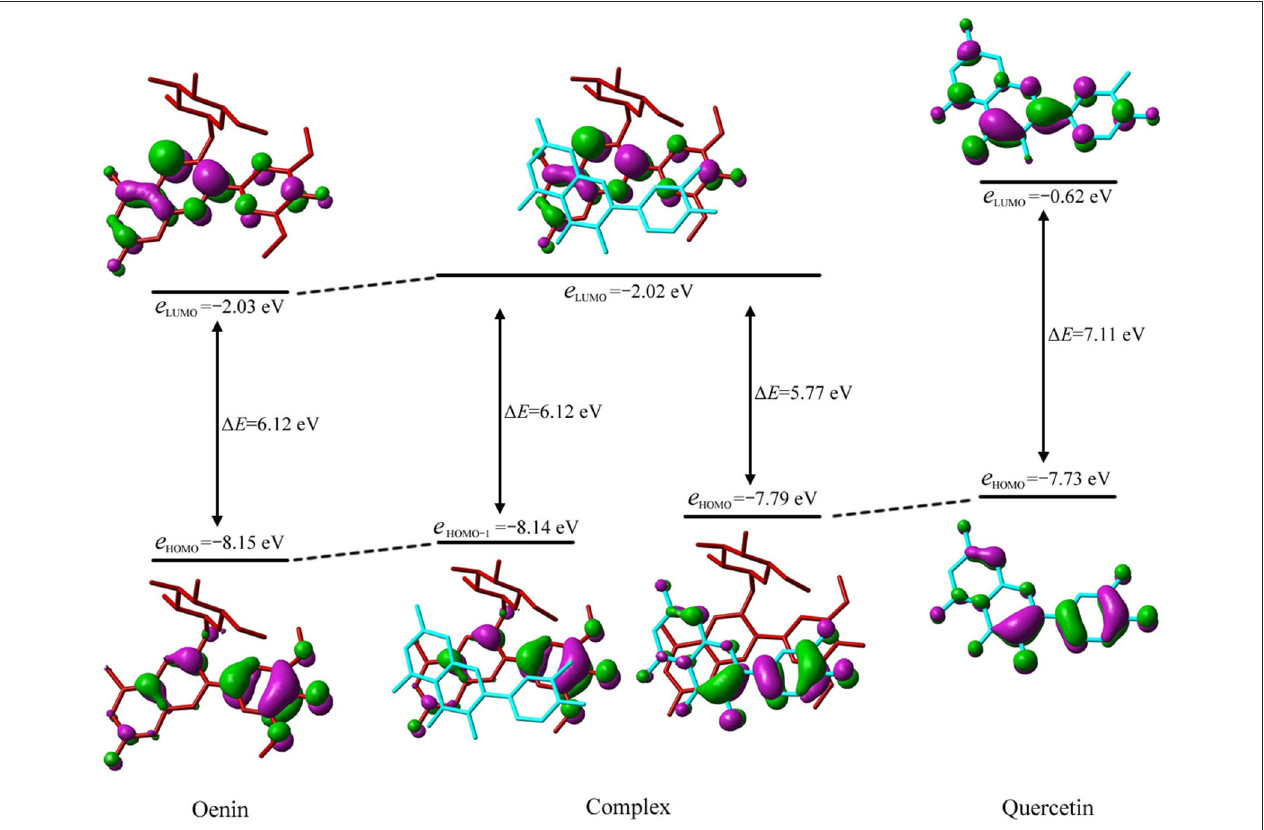
FIGURE 3 | Molecular orbital correlation diagram of oenin, conformer 5 and quercetin. A tube molecular representation was adopted for oenin in red and quercetin in cyan.